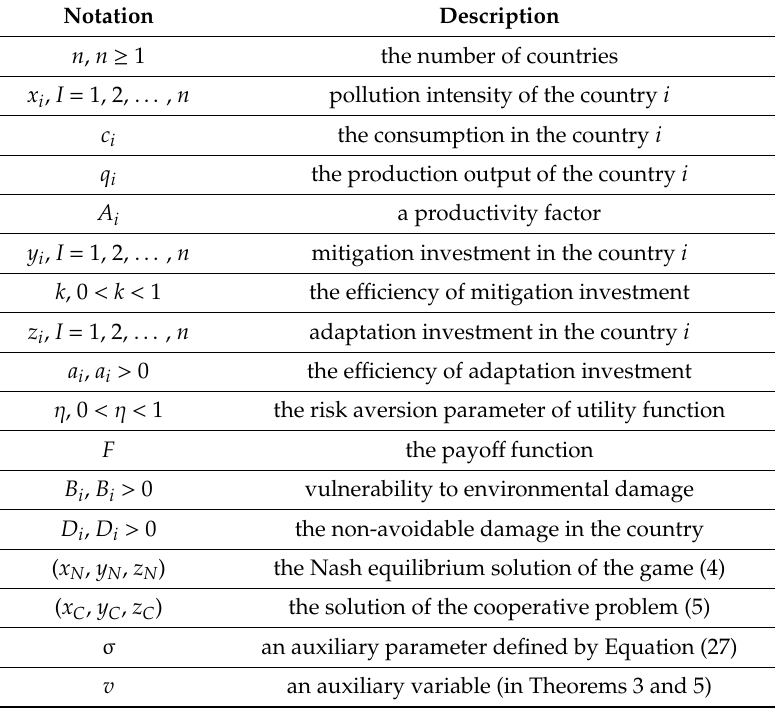
Table 1. The list of used parameters and